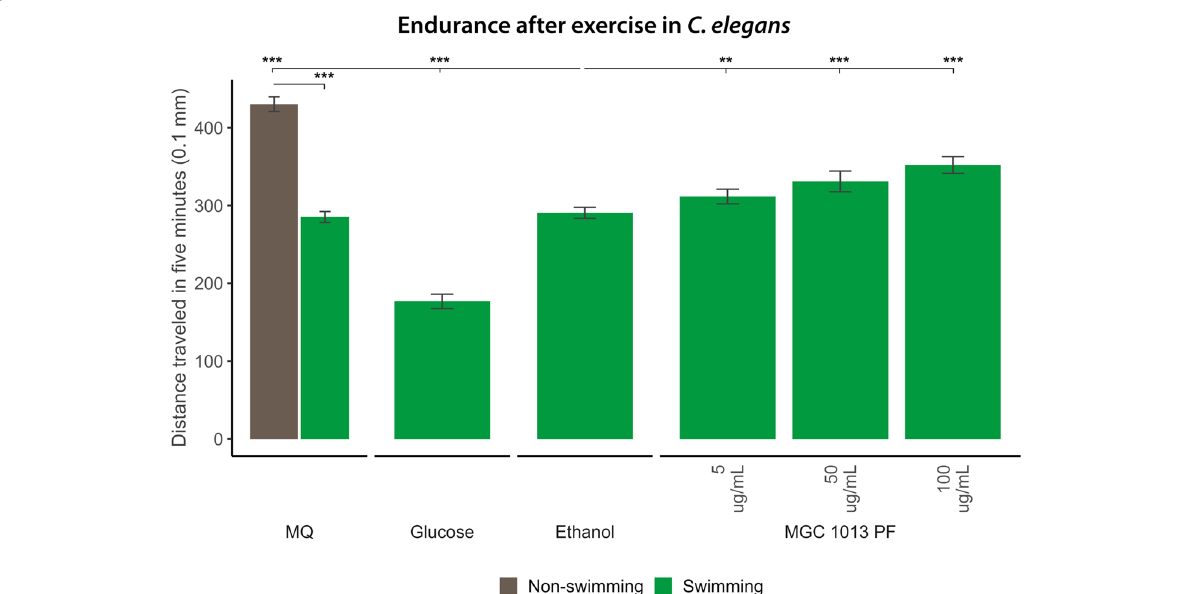
Fig. 8 Effect of nematode treatment with the polar fraction (PF) of MGC 1013 on endurance after exercise. Nematodes treated with different concentrations of 5, 50, and 100 μg/mL of the PF of MGC 1013 were forced to swim during 120 min. After this the distance travelled within the first 5 min on a solid agar medium was scored. After swimming nematodes travel a shorter distance (green Milli‑Q water (MQ) untreated control group) when compared to the non‑swimming control group (brown bar). Glucose treatment does not enhance performance. Nematode treatment with the PF of MGC 1013 enhances the travel distance of nematodes after swimming in a dose responsive manner, indicative for enhancing overall fitness or energy levels. Mann‑Whitney U tests were used to compare the vehicle control conditions (ethanol) to all other conditions, as well as to compare MQ conditions between exercise and rest. Brown bars denote the rest condition (non‑swimming); green bars denote the exercise condition (swimming); *** false discovery rate (FDR)‑corrected p < =